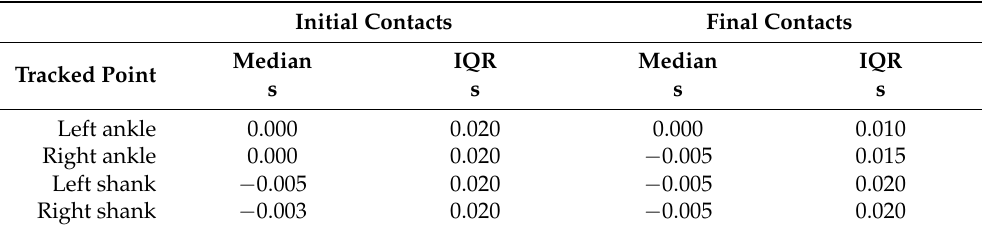
Figure 3. Time errors for initial ( left ) and final ( right ) contacts detection, for each of the different tracked points. Table 6. Time errors for the correctly detected gait events. Note that 0.005 s corresponds to 1 sample period, given the sampling frequency of 200 Hz.